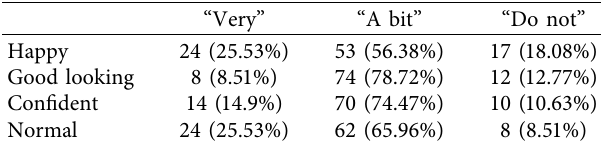
Table 3: Responses of the Moroccan participants to the MIQ positively worded questions.